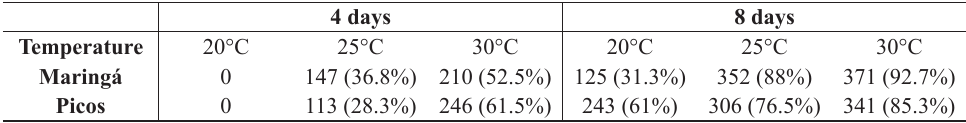
Number of germinated seeds of mandacaru collected in Maringá (Southern region of Brazil) and Picos (Northeastern region of Brazil) at 20, 25 and 30°C after four and eight days.